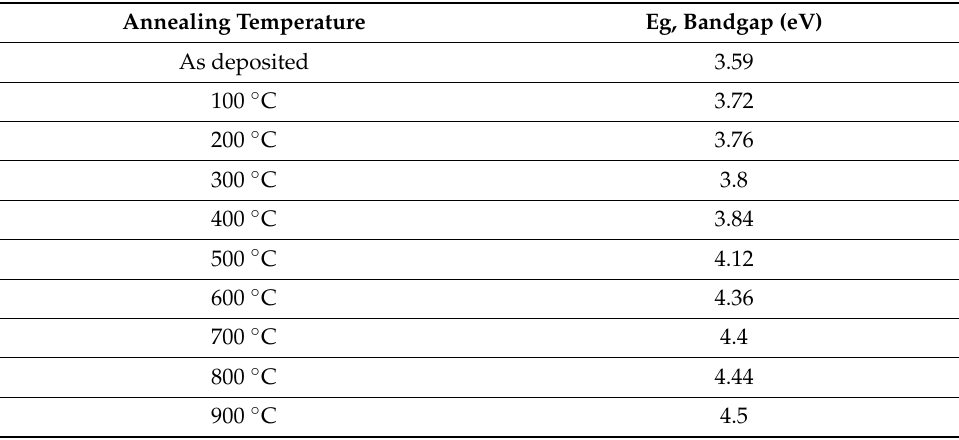
Figure 7. Tauc plot of the CuGa 2 O 4 thin films annealed at different temperatures. Table 2. Optical bandgap values obtained for CuGa 2 O 4 thin films.